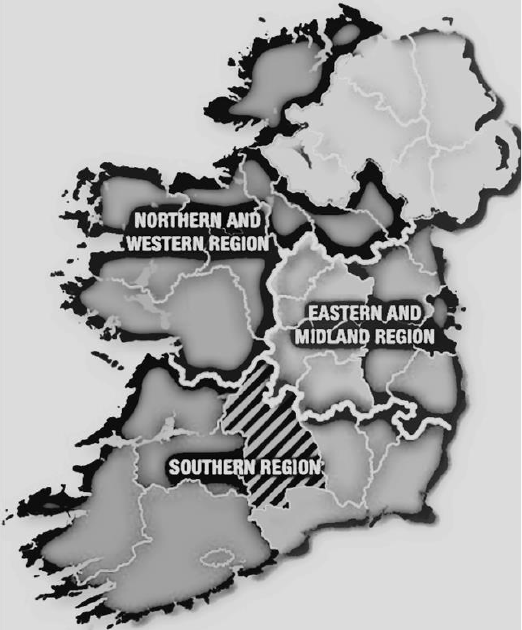
Figure 1. Map of regions in Ireland that was used in this study (https://www.nwra.ie/about/ (accessed on 28 November 2022)).